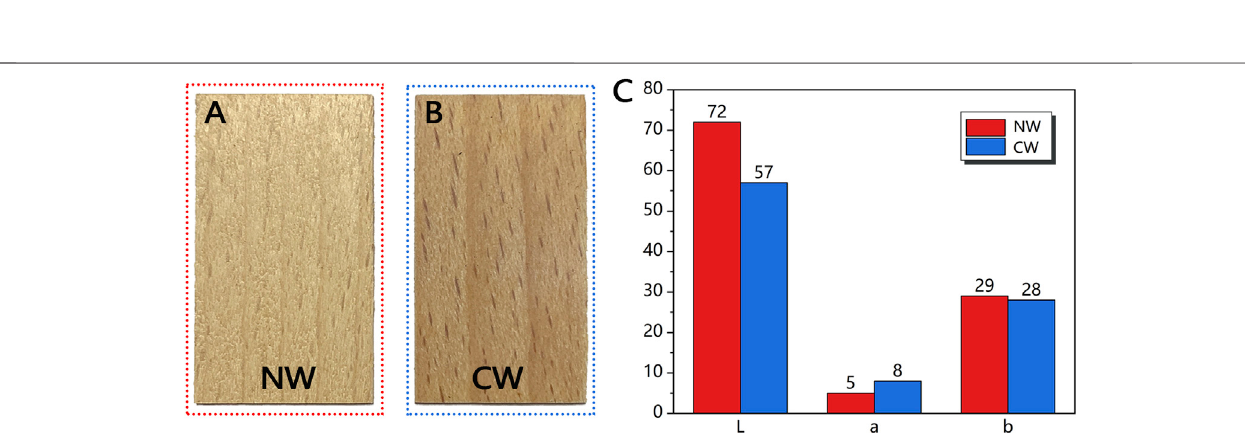
Color Difference Analysis